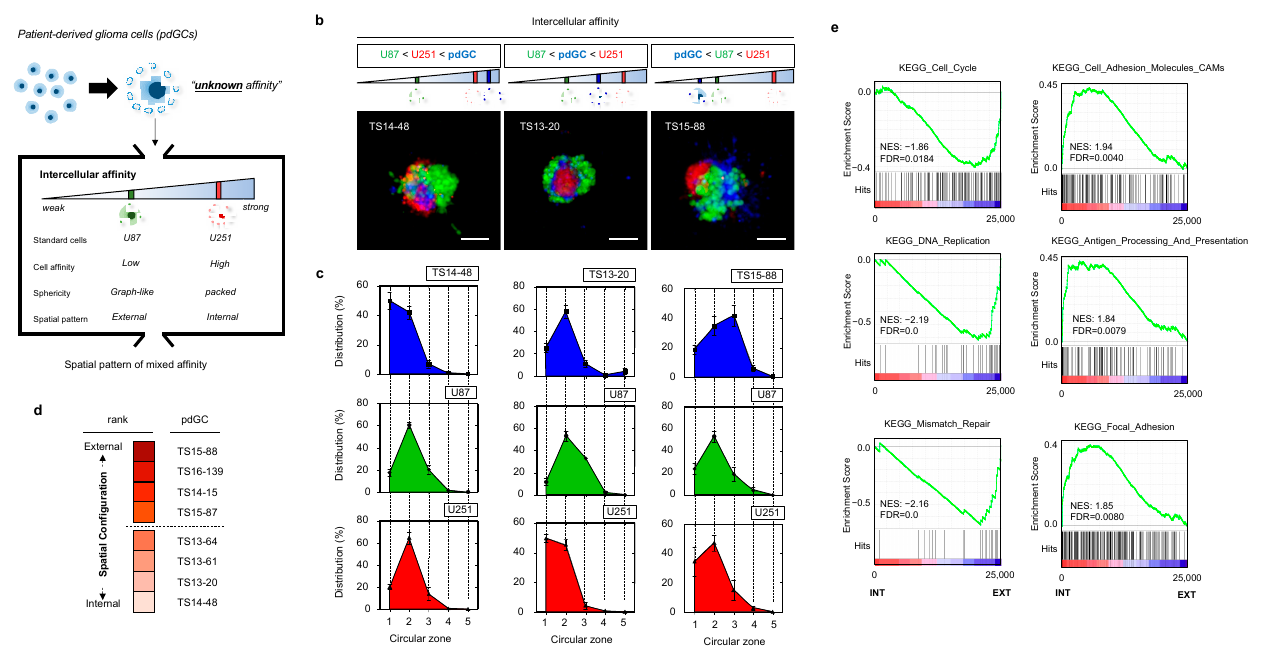
Figure 3. Formation and analysis of MAs of patient-derived glioblastoma cells (pdGCs) and the phenotypic associations thereof. ( a ) Multicellular self-assembly of pdGCs with unknown intercellular affinity compared to those of the U251 and U87 glioblastoma cell lines. ( b ) Representative fluorescence images of pdGC–U251–U87 MAs. Scale bar: 100 µ m. ( c ) Spatial configurations (3D) within pdGC–U251–U87 MAs. ( d ) pdGC scoring based on 3D spatial configuration. ( e ). Enrichment score plots of the distinct KEGG phenotypes of the internal and external subgroups.